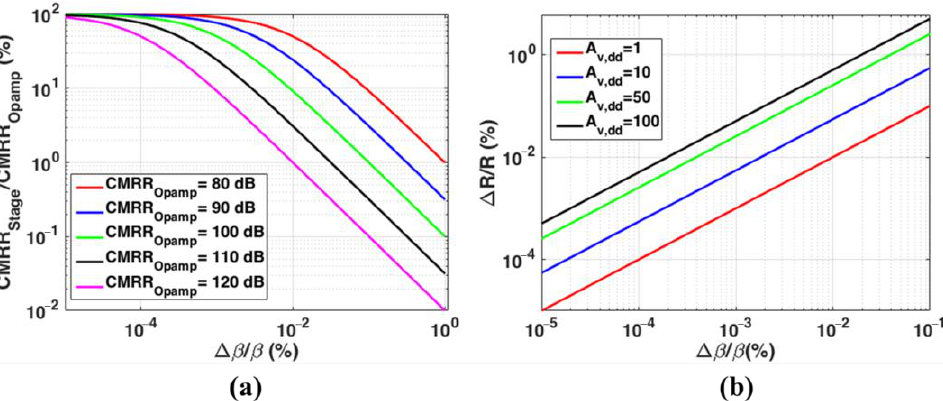
Figure 6. ( a ) Percent degradation in the ratio of the CMRR of a fully differential stage ( 𝐶𝑀𝑅𝑅 𝑆𝑡𝑎𝑔𝑒 ) and Opamp typical CMRR ( 𝐶𝑀𝑅𝑅 𝑂𝑝𝑎𝑚𝑝 ) for various 𝐶𝑀𝑅𝑅 𝑂𝑝𝑎𝑚𝑝 , versus percent change in match- ing ratios of peripheral resistors constructing the feedback network ( Δ𝛽/𝛽 ); ( b ) Percent resistance tolerance ( Δ𝑅/𝑅 ) for various differential stage gain, 𝐴 𝑣,𝑑𝑑 , versus percent feedback ratio mismatch ( Δ𝛽/𝛽